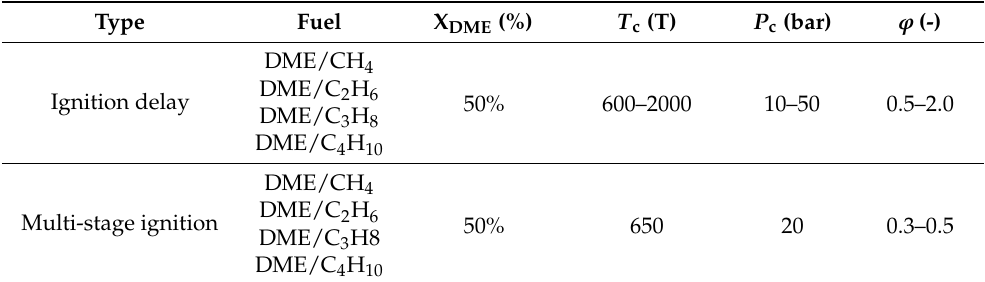
Table 1. Mixture compositions and initial conditions for 0-D homogeneous batch reactor